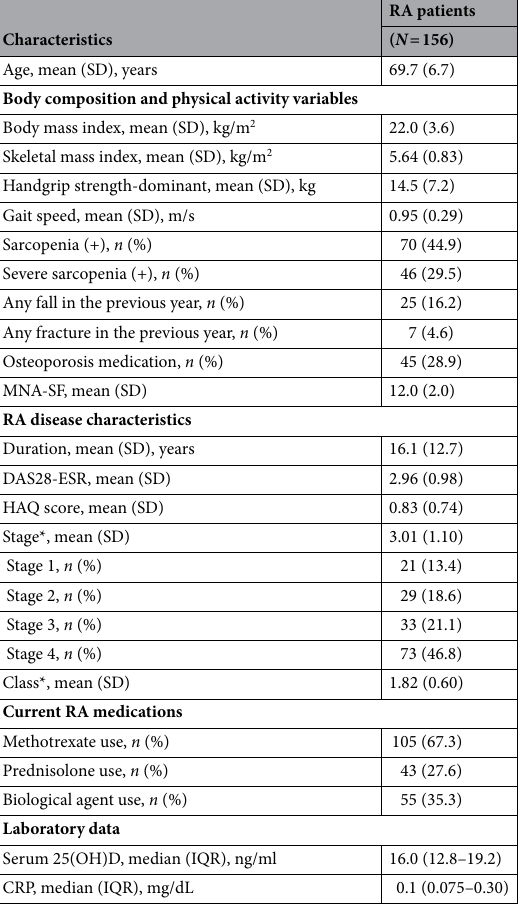
Table 1. Characteristics of this study population. Data are presented as the mean (standard deviation (SD)) or as the median (interquartile range (IQR)) for continuous variables, and as numbers (%) for categorial variables. RA rheumatoid arthritis, MNA-SF Mini Nutritional Assessment Short-Form, DAS28 disease activity score using 28 joints, VAS visual analogue scale, HAQ health assessment questionnaire. *Steinbrocker’s